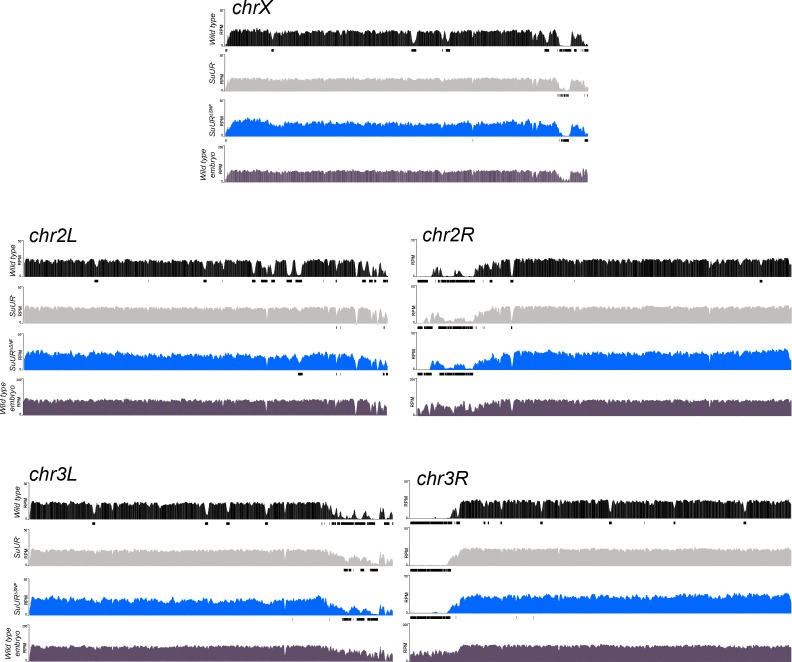
Genome-wide copy number profile of the SuURΔSNF mutant.Illumina-based copy number profiles of all chromosome arms except the fourth for larval salivary glands of the indicated genotypes and wild type 0 – 2 hr embryos in which DNA is fully replicated. Black bars below each profile represent called underreplicated regions.